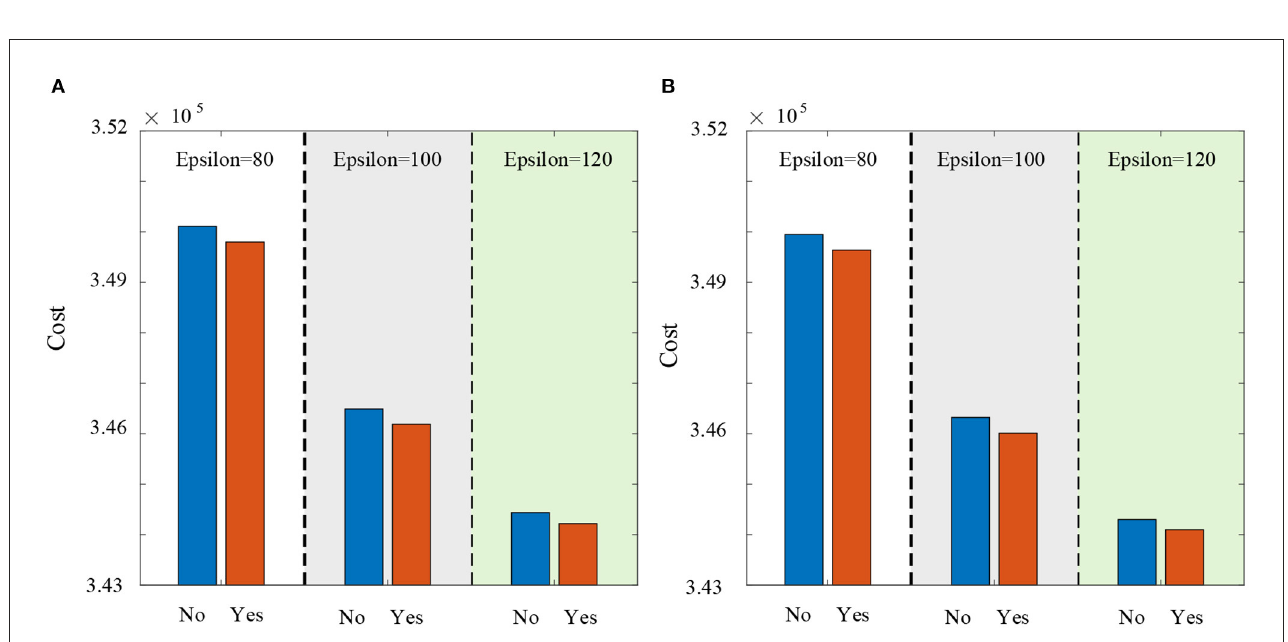
FIGURE7 The influence of lateral transshipment strategy. (A) The influence of lateral transshipment strategy under the supply chain disruption risks. (B) The influence of lateral transshipment strategy under the normal operation of supply chain.